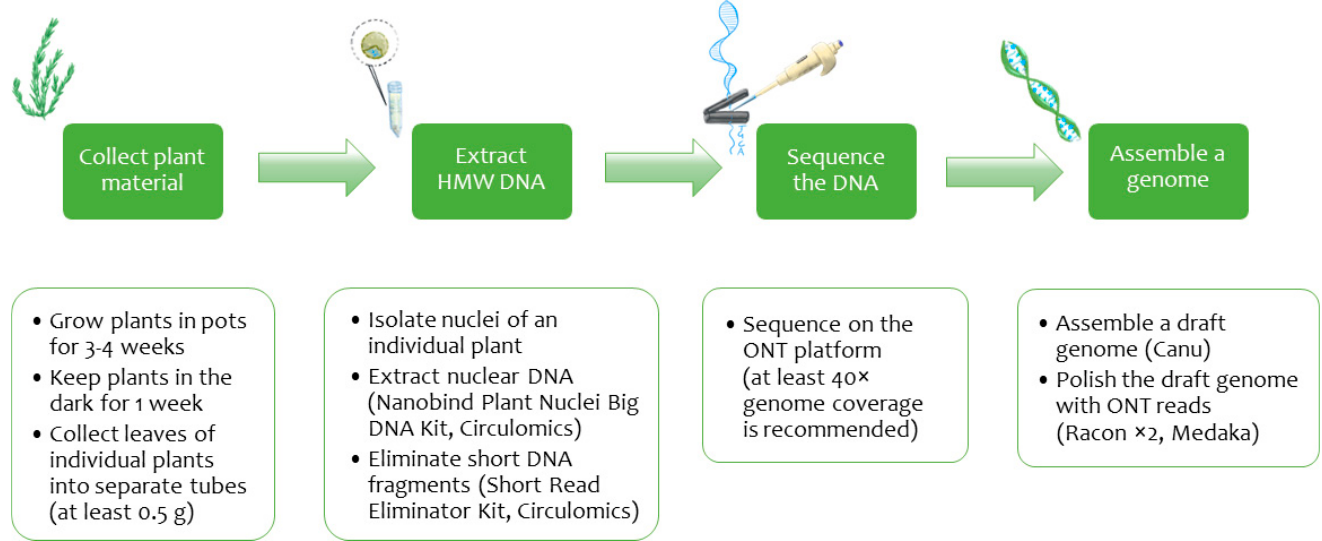
Figure 1. Scheme of obtaining a high-quality flax genome assembly from ONT